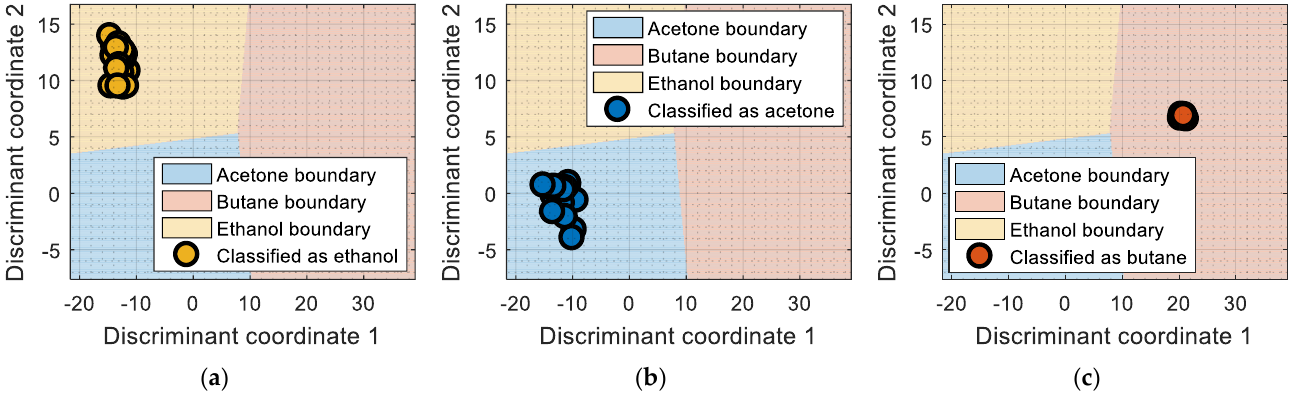
Figure 6. LDA validation results processing the eNose data as raw resistance. The datasets shown contained samples of: ( a ) ethanol; ( b ) acetone; ( c ) butane.